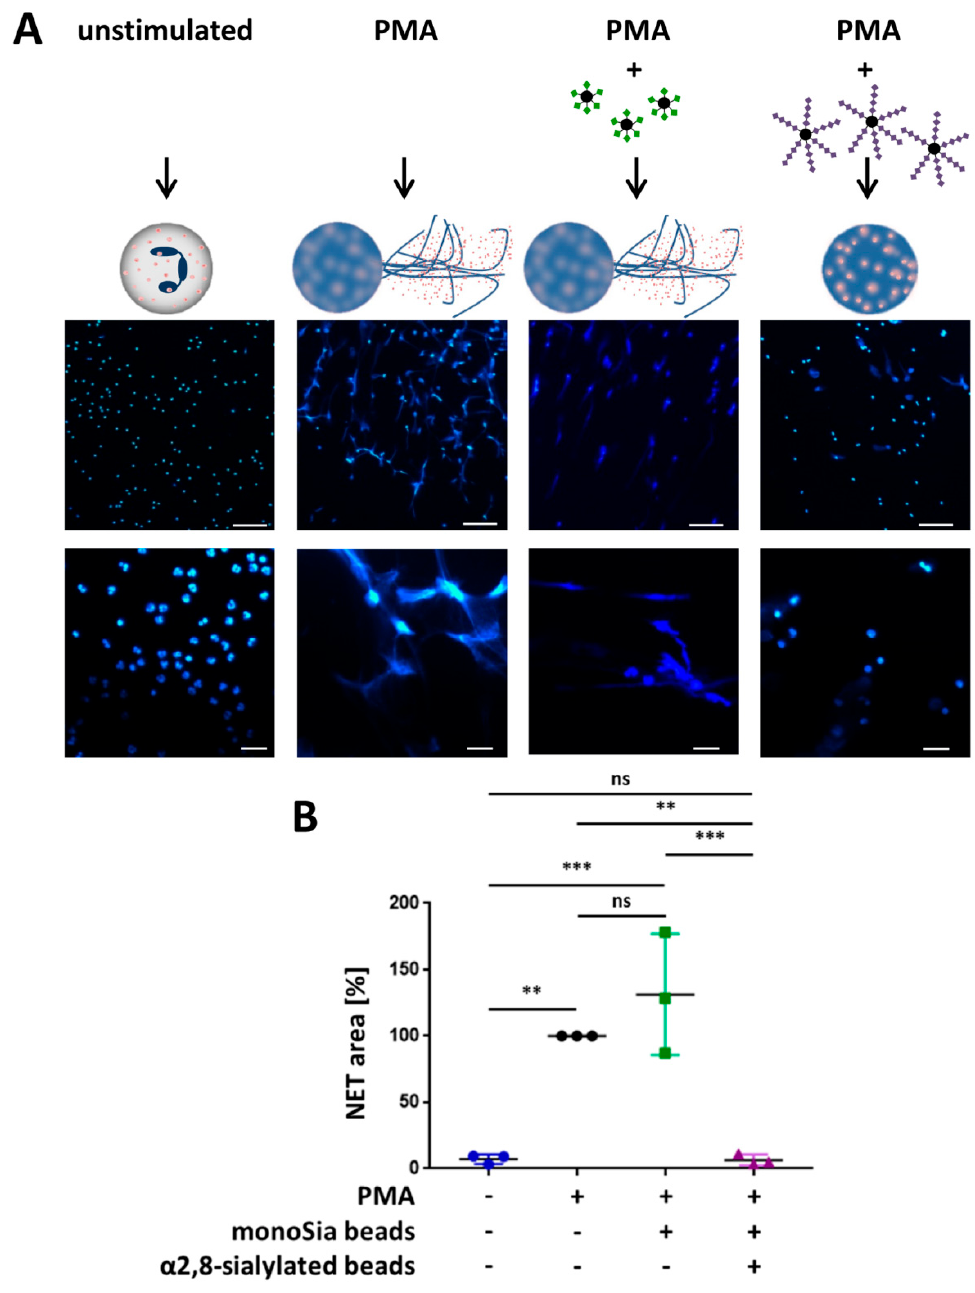
Figure 5. α 2,8-sialylated particles inhibit NET release. ( A ) Fluorescence staining (DAPI; blue) of neutrophils without any stimulation of neutrophils, stimulated with 20 nM PMA for 4 h, and of neutrophils stimulated with 20 nM PMA coincubated with monosialylated particles or α 2,8-sialylated particles for 4 h. Upper scale bar: 100 µm, lower scale bar: 20 µm. ( B ) Analysis of the NET area (%). The analysis was performed using Cell Profiler 2.2.0. The NETosis area (%) was calculated by determining the blue fluorescent areas (DAPI). PMA inducement was set to 100%. Mean values ( n = 3) and standard deviations are displayed. ANOVA and multiple comparison Tukey test were applied. Significant differences are given as follows: ns, not significant, ** p ≤ 0.01 and *** p ≤ 0.001.